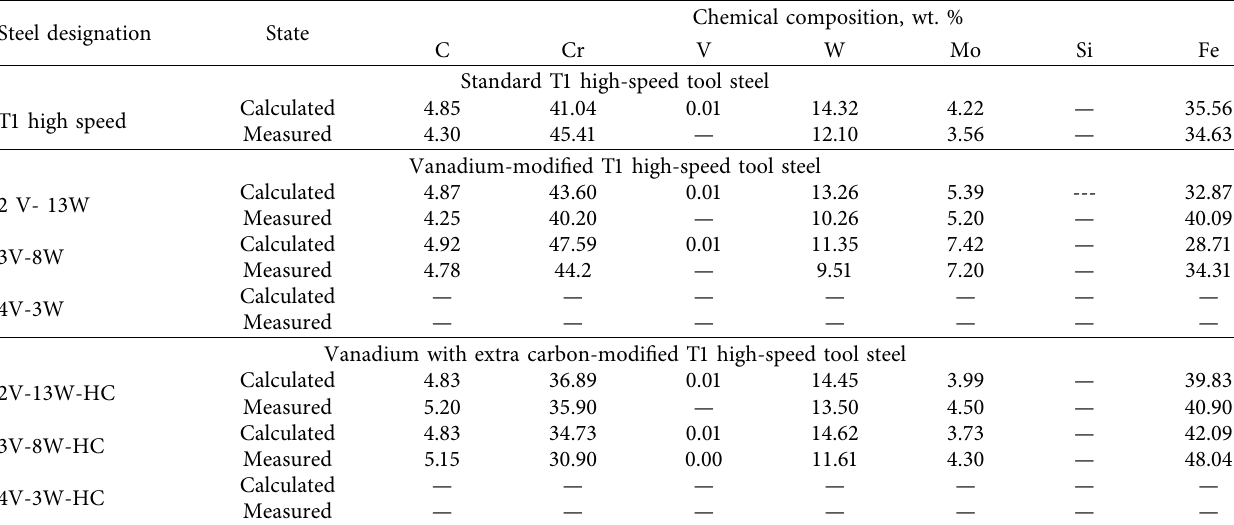
Table 5: Chemical composition of M 23 C 6 carbide for T1 high-speed tool steel and its diferent variants (as solidifed). Steel designation